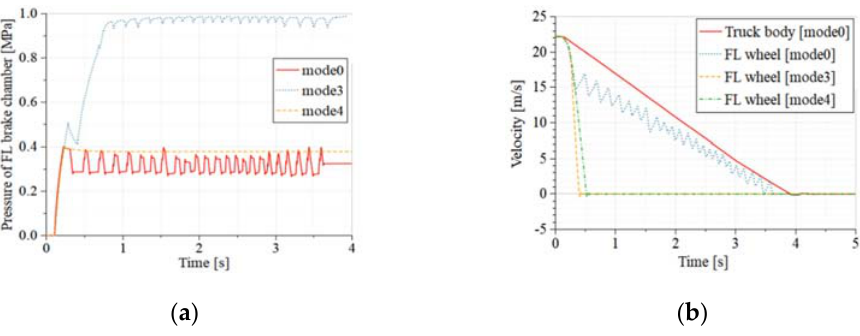
Figure 22. ( a ) Pressure of brake chamber at mode 0 , mode 3 , and mode 4 ; ( b ) velocity of the truck body and wheels at mode 0 , mode 3 , and mode 4 .